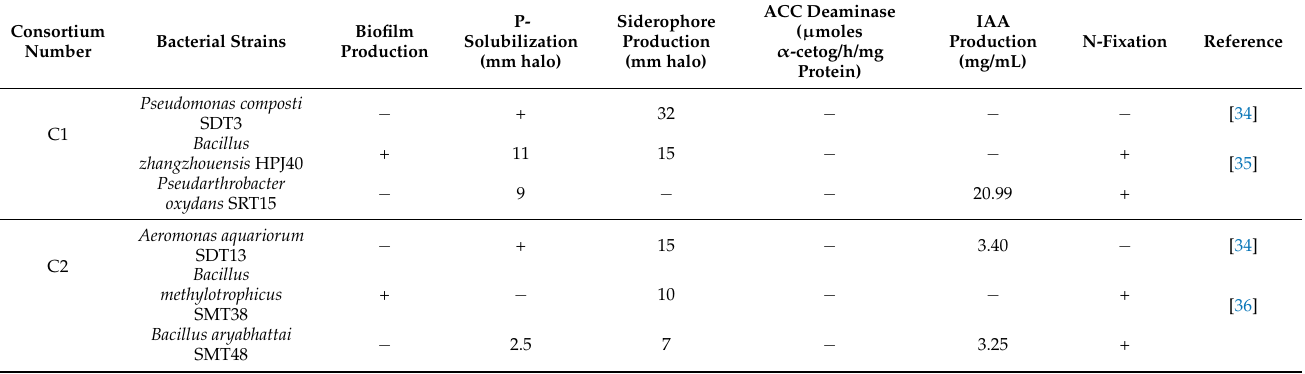
Table 1. Consortia design and plant growth-promoting rhizobacterial (PGPR) trait